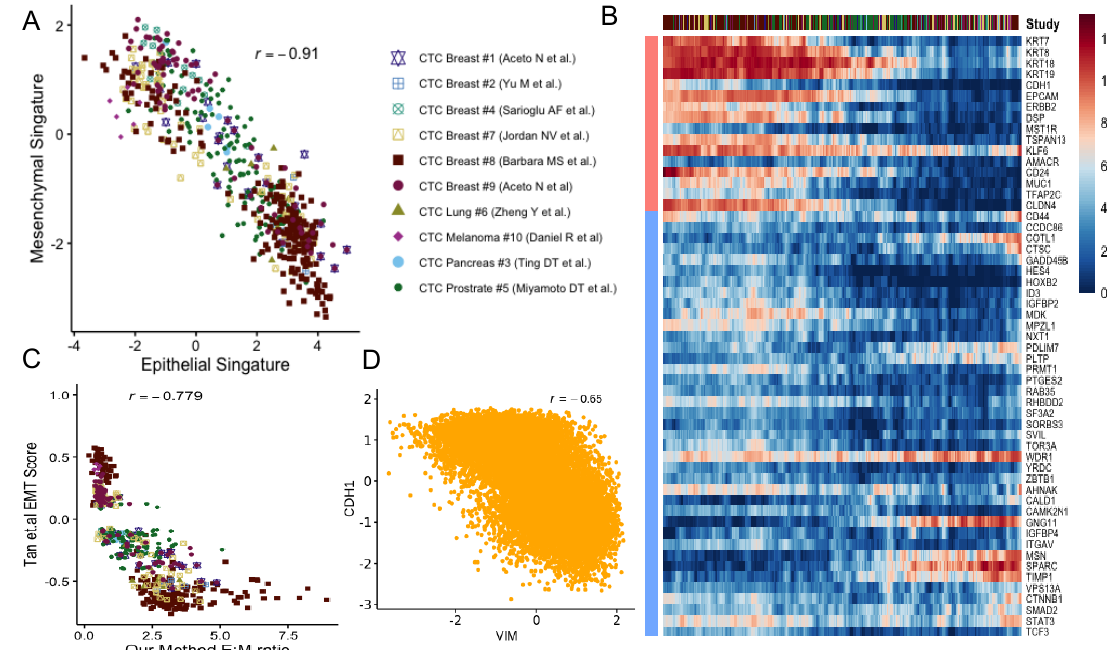
Figure 2. Epithelial-mesenchymal transition in cancer metastasis: ( A ) Scatter plot showing anti-correlation between epithelial and mesenchymal phenotypes across studies. ( B ) The moving average smoothen log(expression+1) of CTC dataset on epithelial and mesenchymal markers where cells are ordered based on their repctive E:M score as described in the main methods. ( C ) Scatter diagram depicting the correspondence between E:M score and the EMT score proposed by Tan and colleagues [43]. ( D ) CDH1-VIM anti-correlation observed due to simulation of EMT associated regulatory